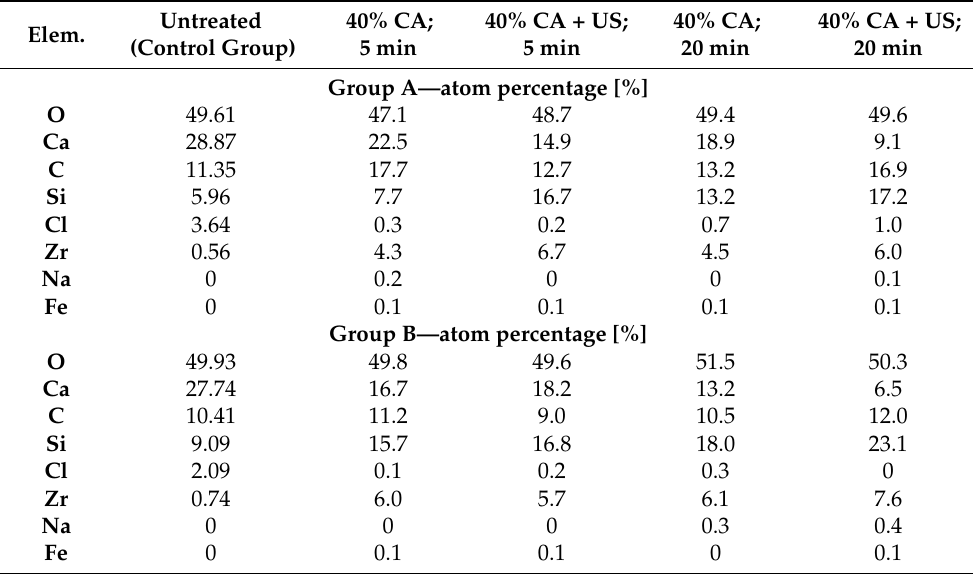
Table 2. Chemical composition (atom percentage) of Biodentine samples’ surface after 45-min (group A) and 24-h (group B) setting time.